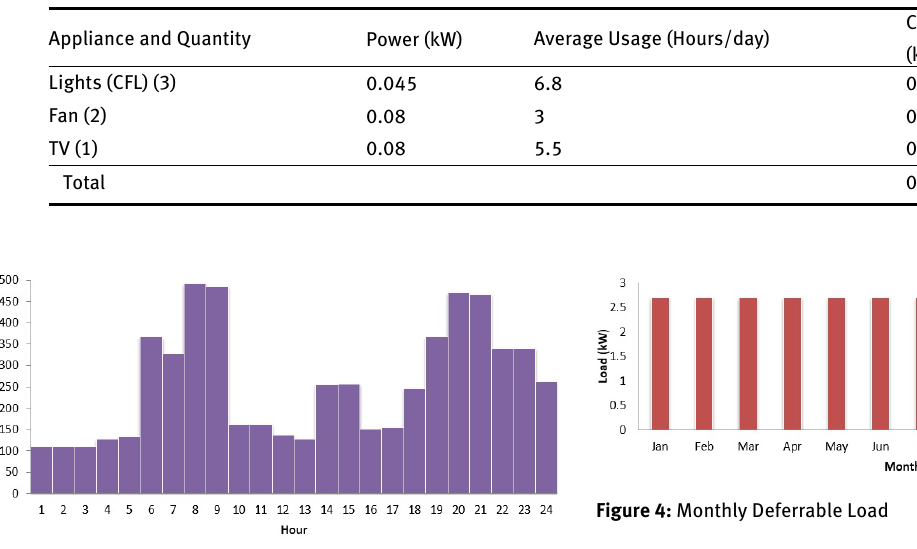
Figure 2: Daily Load Profile